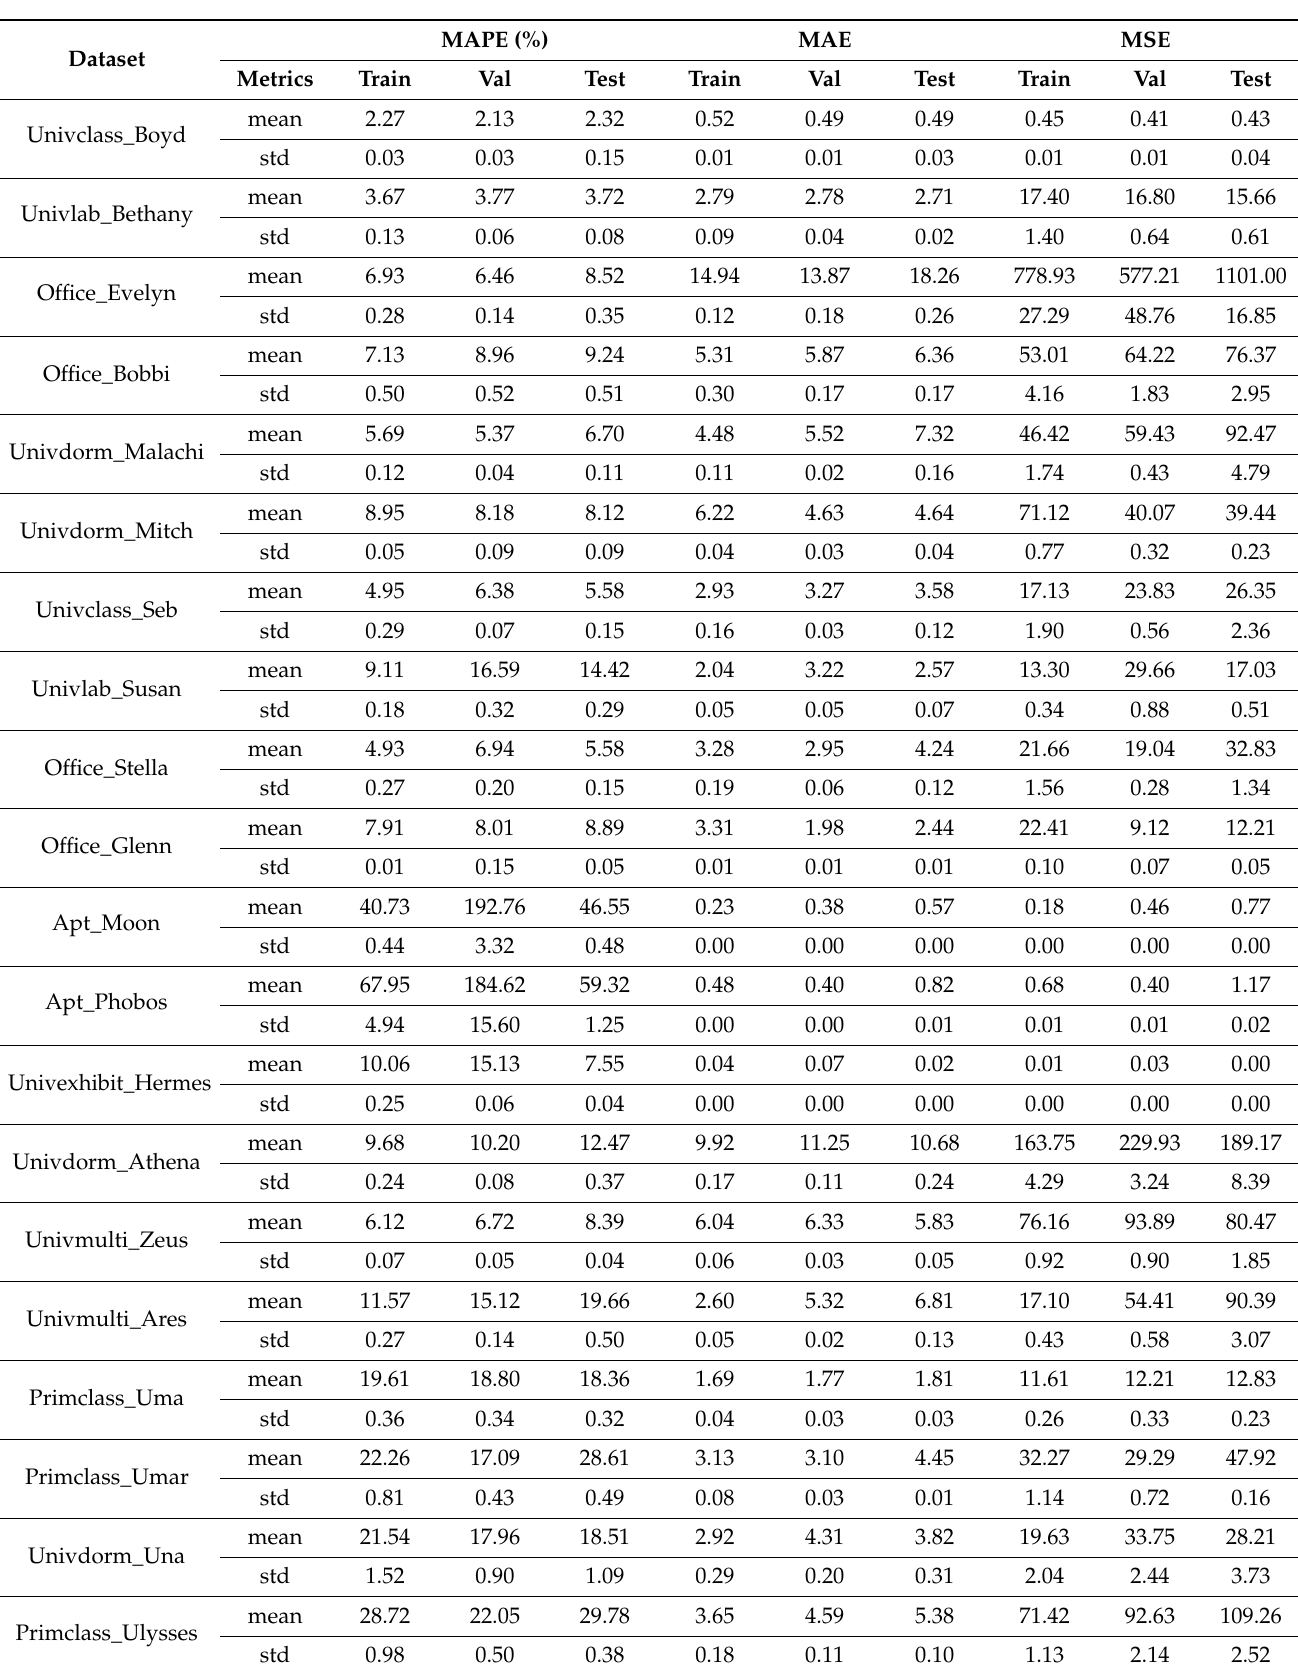
Table 10. The MAPE, MSE, and MAE of forecasting using WT-LSTM